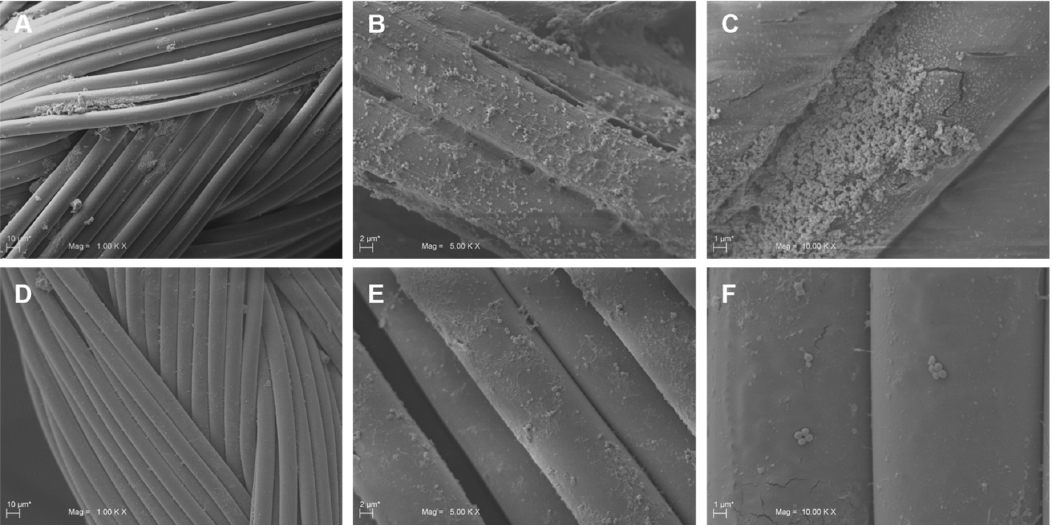
Figure 4. Representative SEM images of sutures untreated and treated with the medical device (MD). Panels A , B , and C represent different magnifications of untreated sutures with S. aureus cells adhered on the surface of the threads. S. aureus aggregates forming a well-developed biofilm were visible on panels B and C . On the contrary, few scattered cells were attached on the suture surface of MD-treated samples ( D , E , F ).